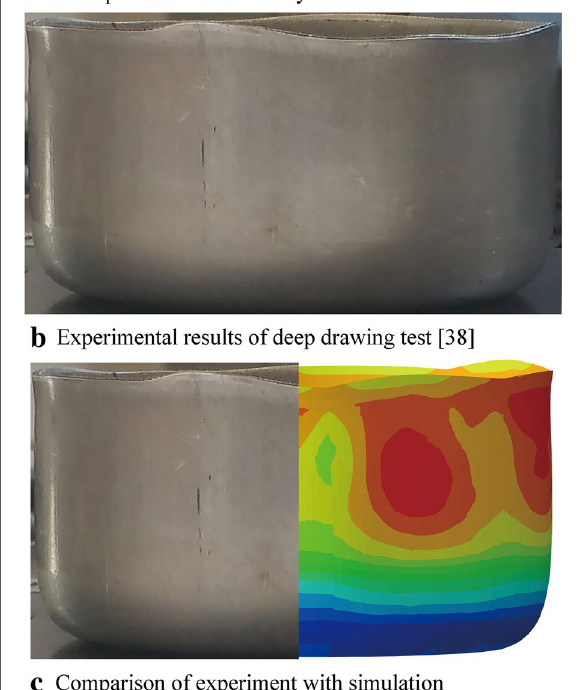
Figure 6 Comparison of the simulation results for each method with the experimental results